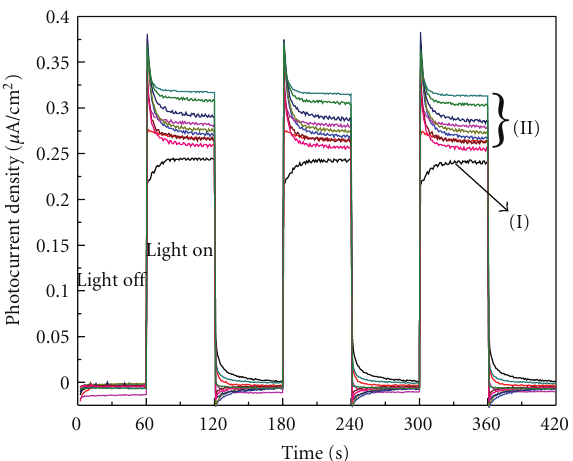
Figure 4: Photocurrent response of (I) undoped TNT and (II) N- doped TNT arrays samples.